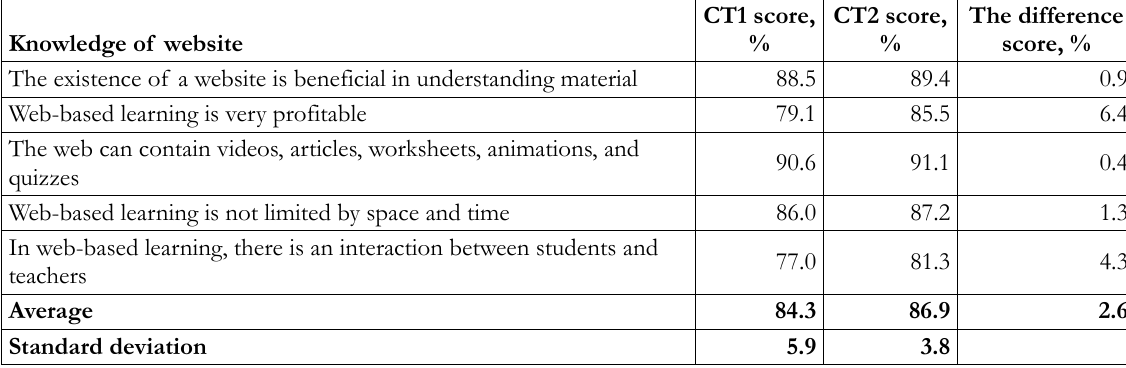
Table 2. The scores of knowledge of